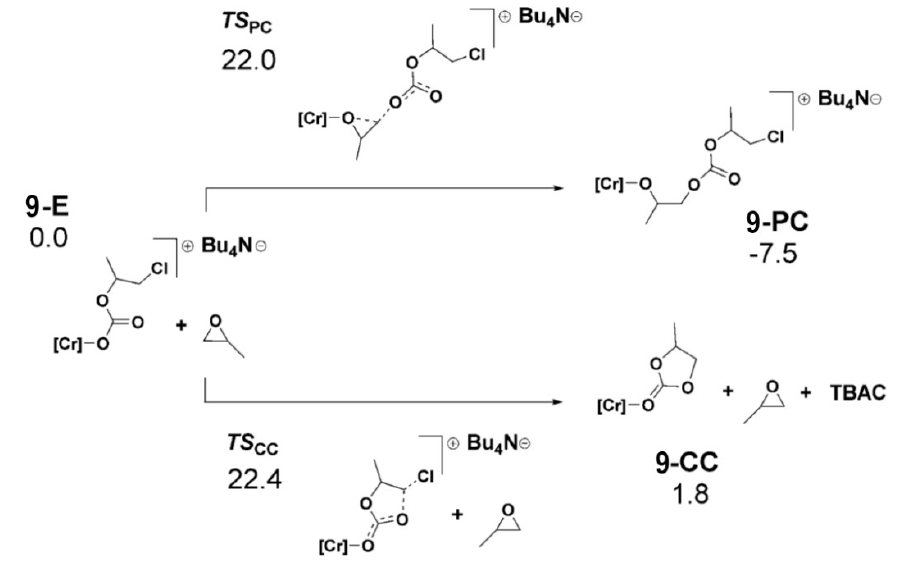
Scheme 3. Free energy profile evaluating the cyclization versus polymerization paths for the coupling of PO and CO 2 promoted by complex 9 [61]. Reprinted with permission from ref. 61. Copyright (2020) John Wiley and Sons.